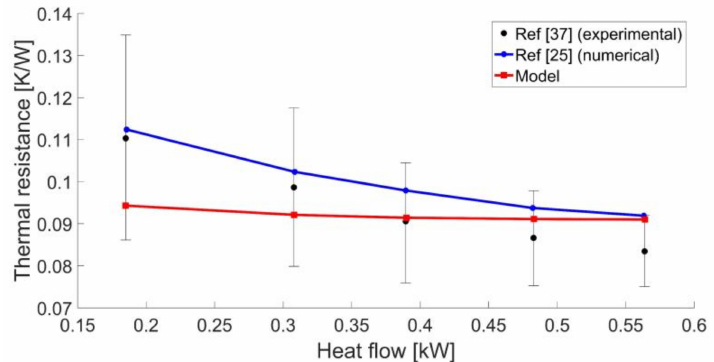
Figure 4. Overall thermal resistance results and comparison with the experiments by Song et al. [37] and the numerical model by Song et al.